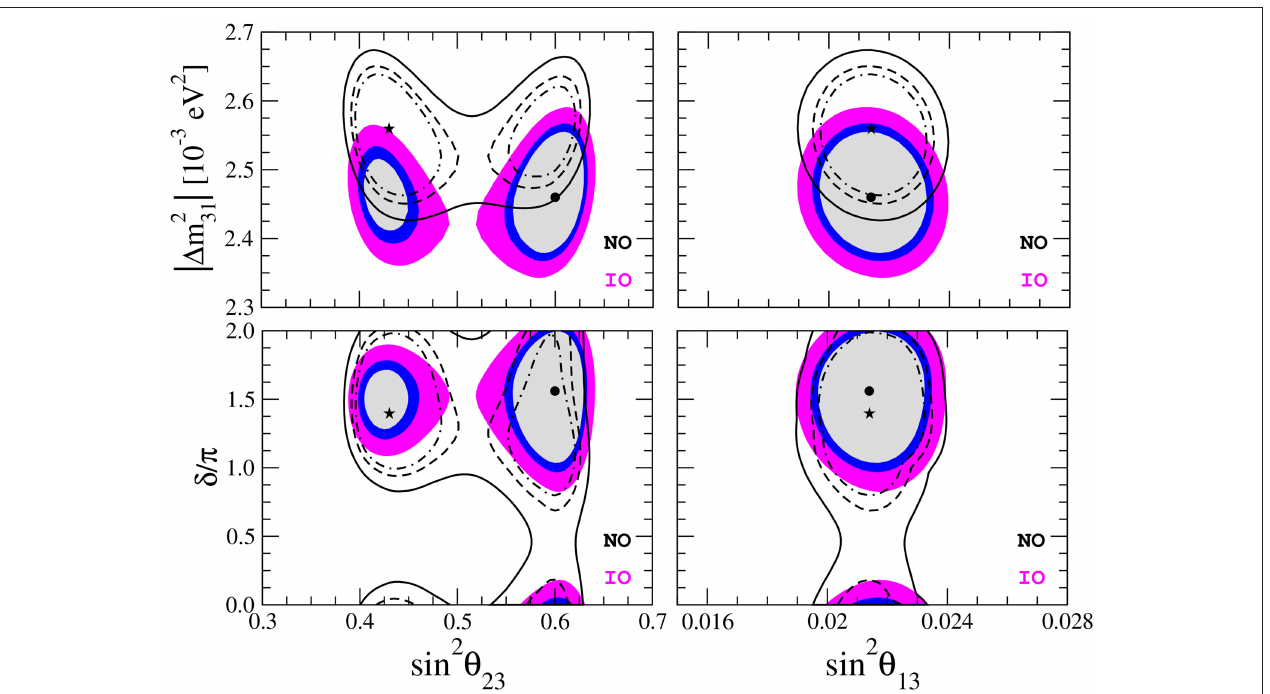
1 m 2 31 1 m 2 31 δ and sin 2 θ 13 δ for normal (lines) and inverted , sin 2 θ 13 , sin 2 θ 23 − | | − | | − −